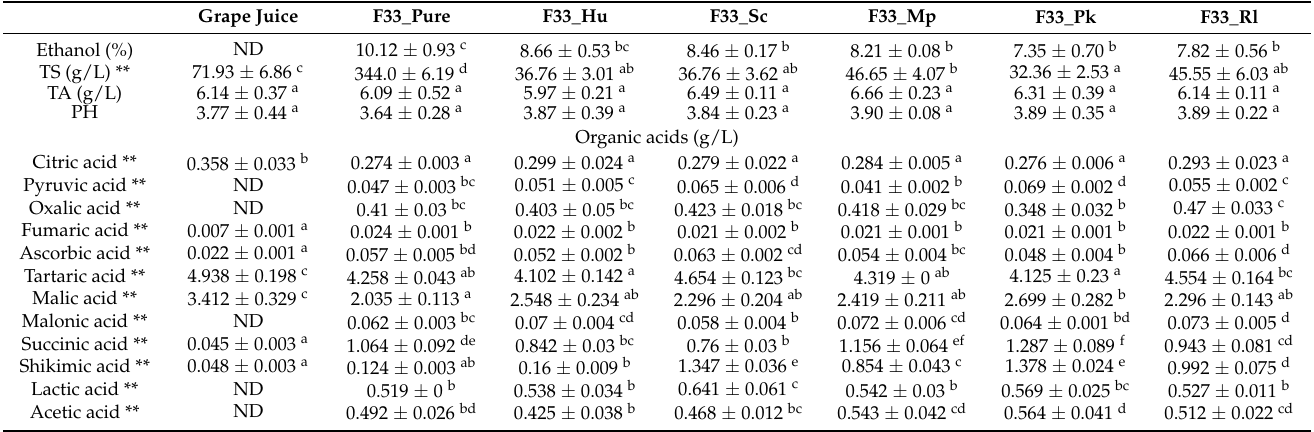
Table 1. Physicochemical parameters of Vidal grape juice and icewines fermented with six fermentation strategies. Grape Juice